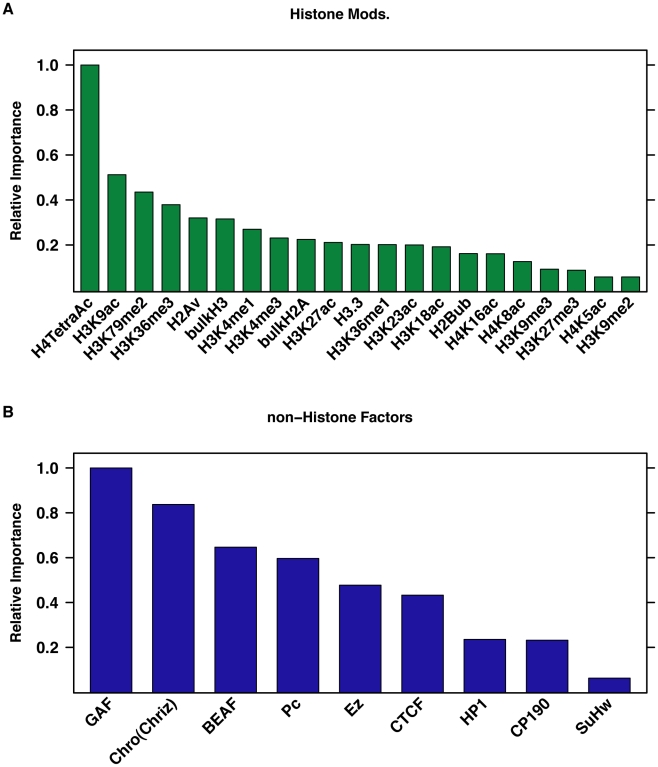
Histone acetylation and GAF occupancy are important covariates in predicting HSF binding intensity.Plotted are the relative values of the sums of the coefficients associated with all rules that reference each covariate in the rules ensemble [20]. Results are shown for (A) the histone variant and modification model and (B) the non-Histone factor model.